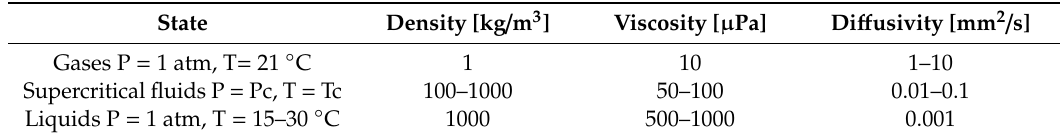
Table 2. Comparison of physicochemical properties of gases, supercritical fluids, and liquids [30]. State